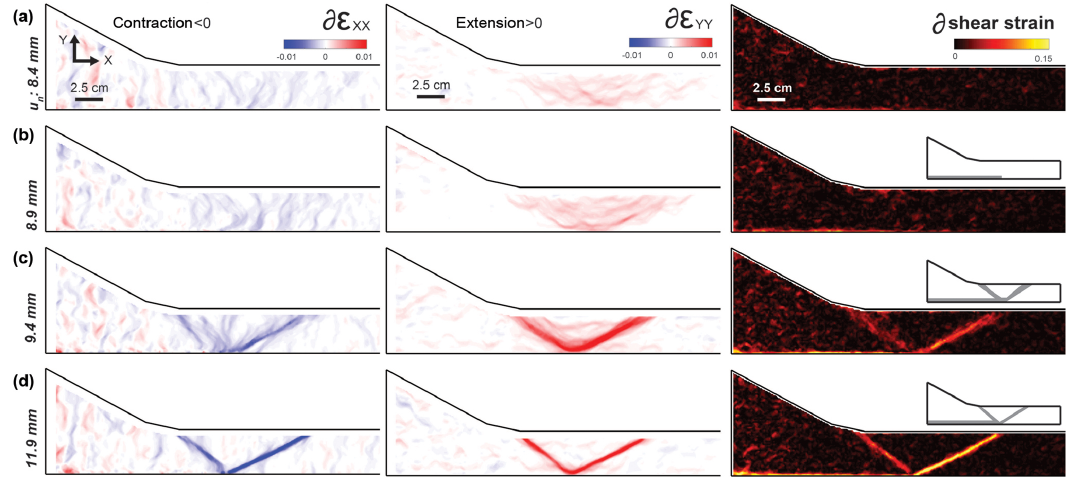
Figure 7. Evolution of strain as the thrust faults develop in experiment E375. Gray regions in sketches in right column indicate portion of strain field that contributes to δW fric , and the remaining white area contributes to δW int . (a) Preceding thrust faulting, the wedge had distributed high horizontal and vertical normal strains. (b) With continued backwall displacement, horizontal contraction and vertical exten- sion shifted toward the region where the thrusts ultimately develop. (c) In the incipient stages of thrust development, horizontal contraction and vertical extension formed broad bands of high strain a few centimeters thick, and shear strain began to localize along both thrusts. At this stage, and in subsequent increments, the forethrust produced higher shear strain than the backthrust. (d) The zones of high horizontal contraction, vertical extension and shear strain localized into discrete zones of higher incremental strains along the thrusts. The progressively localizing normal and shear strains produced the gradually increasing and decreasing δW int coincident with fault development. Preceding fault development, the distributed strains produced maxima values of δW int . As strain localizes onto faults, δW int decreased to near zero, while δW fric increased.